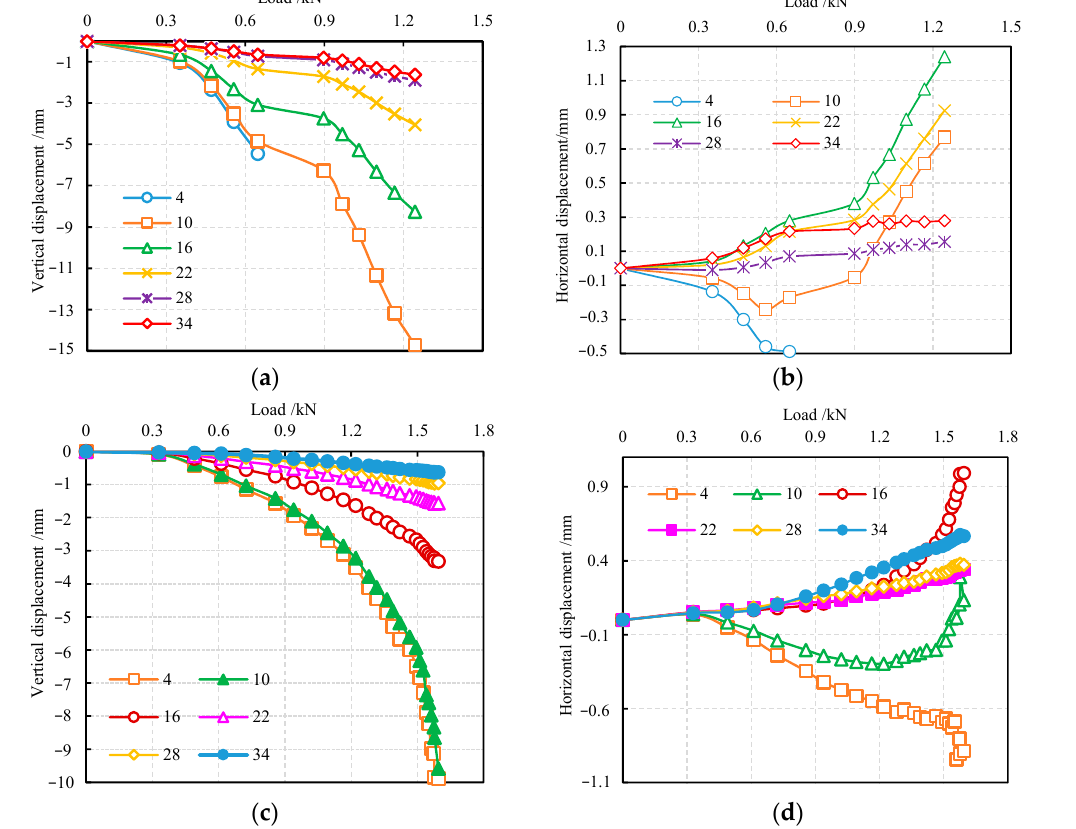
Figure 14. Relationship between displacement and load at different burial depths around the pile: ( a ) vertical displacement in the undisturbed soil; ( b ) horizontal displacement in the undisturbed soil; ( c ) vertical displacement in the sand; ( d ) horizontal displacement in the sand.